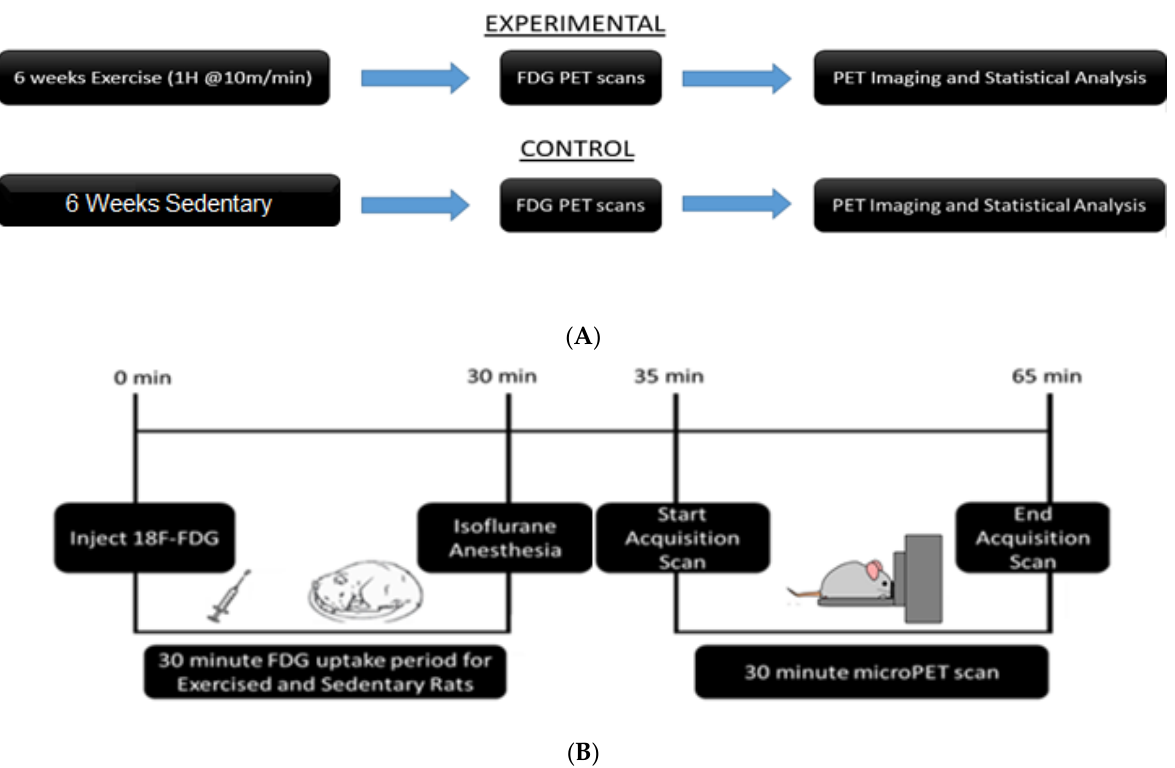
Figure 1. Experimental timelines: ( A ) Animals were divided into exercise and sedentary groups. Exercise animals received 6 weeks of exercise, while sedentary animals remained in their home cages. All animals underwent PET scans after the conclusion of 6 weeks. ( B ) Timeline of PET procedure: Animals were injected with [18F]-Fluorodeoxyglucose (FDG) via intraperitoneal injection. They were returned to their home cages for a 30-min uptake period. At the end of the uptake period, animals were anesthetized and placed in the bed of the PET R4 tomograph machine. PET scans lasted 30 min. After the scan, animals were recovered and returned to their home cages.